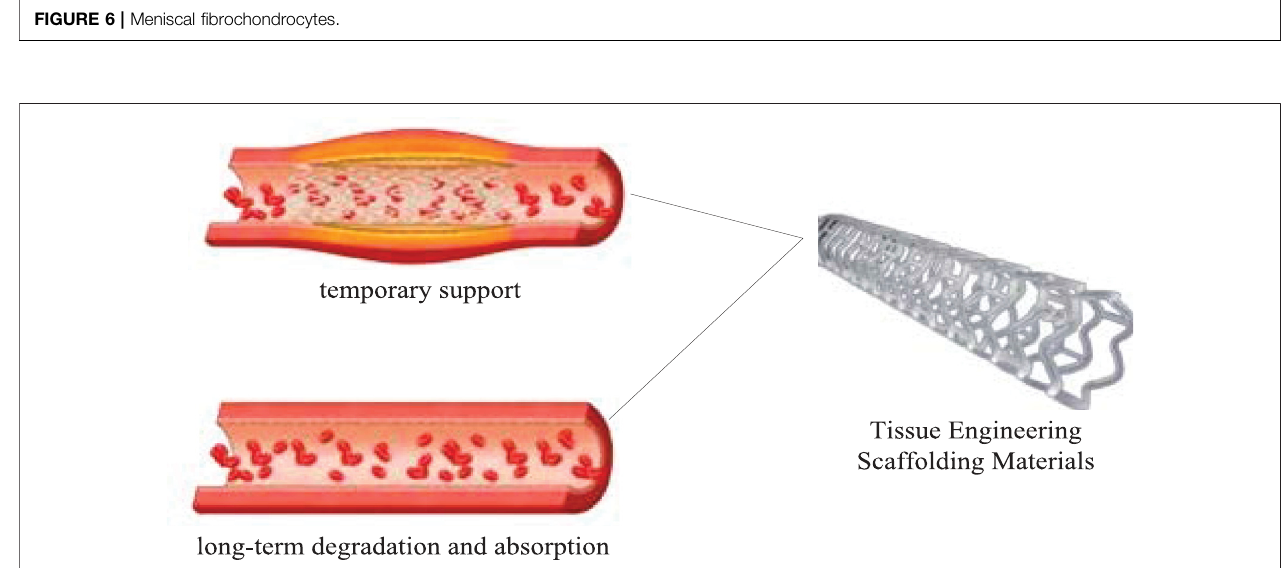
FIGURE 7 | Tissue engineered